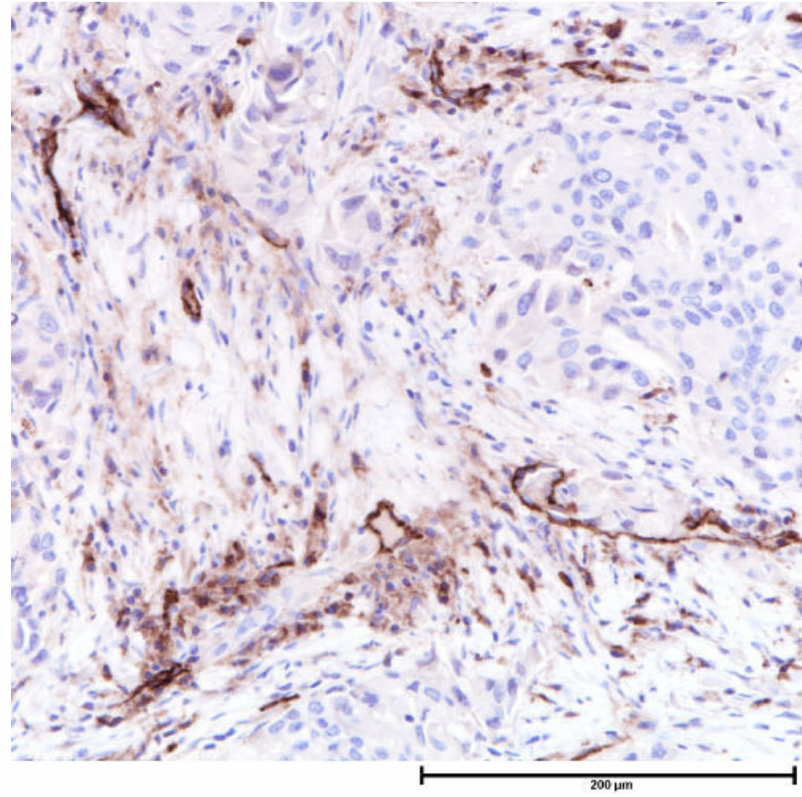
Figure 6. CD31 stain for assessment of microvessel density, CD31, 200 ×